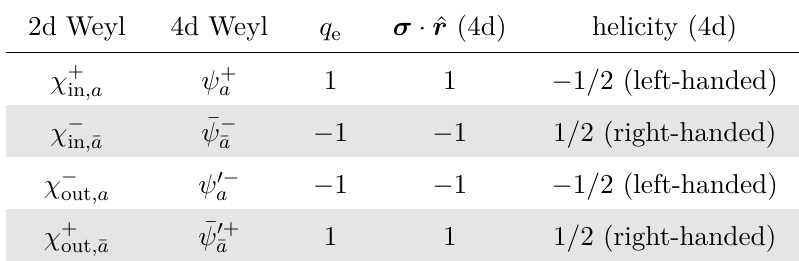
Table 1 . Correspondence between 4d and 2d fermions as a result of the partial wave decomposition, in the presence of the minimal-charge Dirac monopole ( q = 1 ) and in the lowest partial wave m sector. 4d and 2d fields are respectively denoted using ψ and χ . For both ψ and χ , ± denotes the U(1) charge of the fermions. In addition, the 4d fields with or without bar means that the chirality of the field is right- or left-handed, while for the 2d fields in/out means that the fields are incoming/outgoing with respect to the boundary at r = 0 . Flavour indices of the fermions are indicated by a, ¯ a = 1 , . . . , N . We also take the particles in the white entries as a particle, and grey as their antiparticles. Note that the gauge group U(1) turns in to the U(1) symmetry in the A two-dimensional description because of